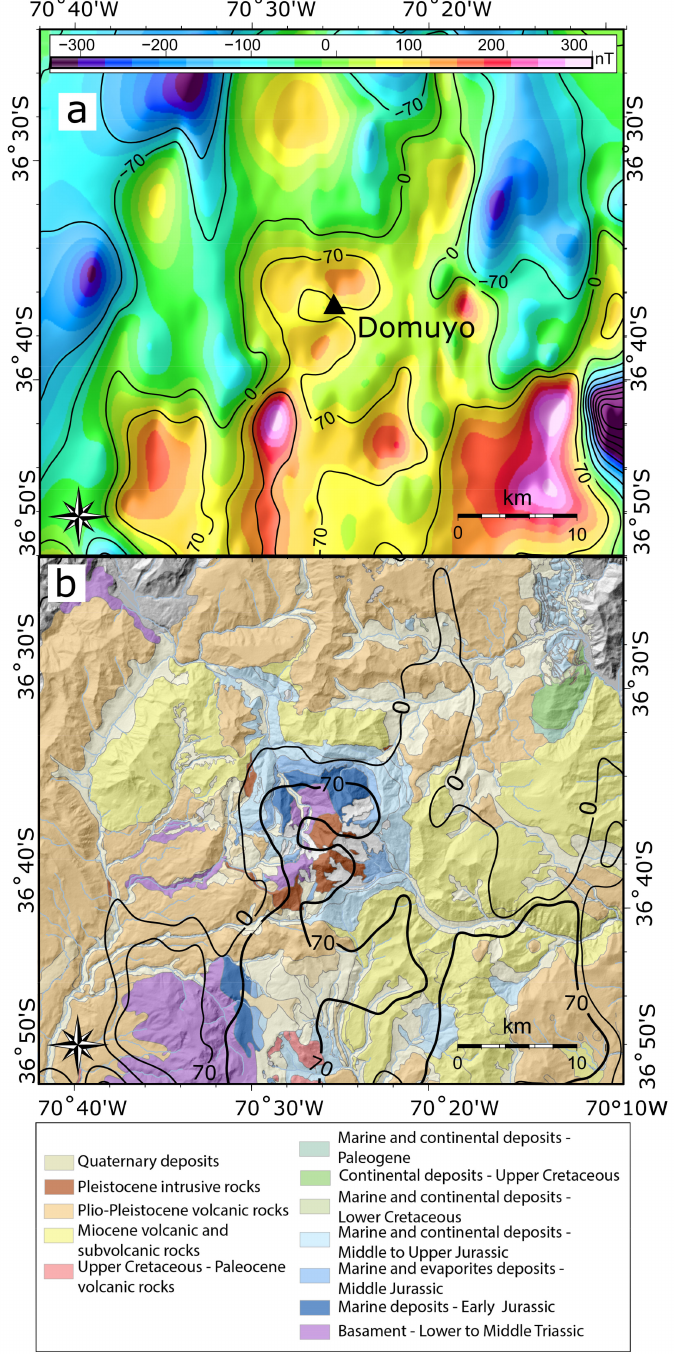
Figure A4. ( a ) Magnetic anomaly in the Domuyo Volcanic Center (DVC) and the surrounding area, delineated by contour lines. Note a semicircular anomaly with values above 70 nT placed over the summit of the DVC which is interpreted as associated with the silicic magmatism represented by the central dome. ( b ) Geologic map of the Domuyo Volcanic Center (DVC) and black contour lines that delineate magnetic anomalies with values above 0 nT. Note peripheral-to-the-central dome positive magnetic anomalies interpreted as magmatic material intruding the Mesozoic rocks at depth, potentially connected with the rims of a collapsed